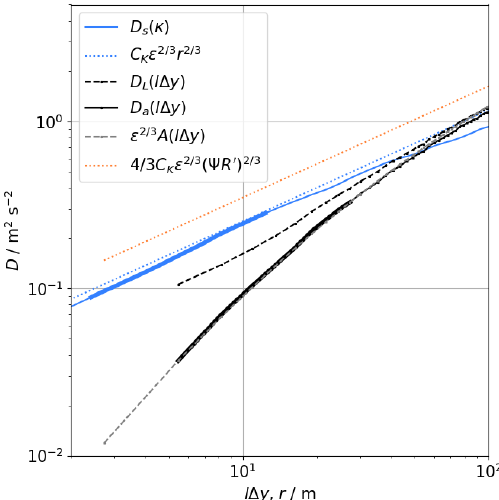
Figure 3. Example of the structure functions of sonic anemometer (blue) and lidar (grey) at 90m of height on 4 April 2019, 12:00– 12:30UTC. The dashed black line shows the measured lidar struc- ture function D L , and the solid black line D a is corrected for the systematic error σ e (see Eq. 9). The grey dashed line gives the model structure function A , and the dotted lines indicate the reconstructed inertial subrange for the calculated values of ε . The parts with bold lines are those ranges that are used for the structure function